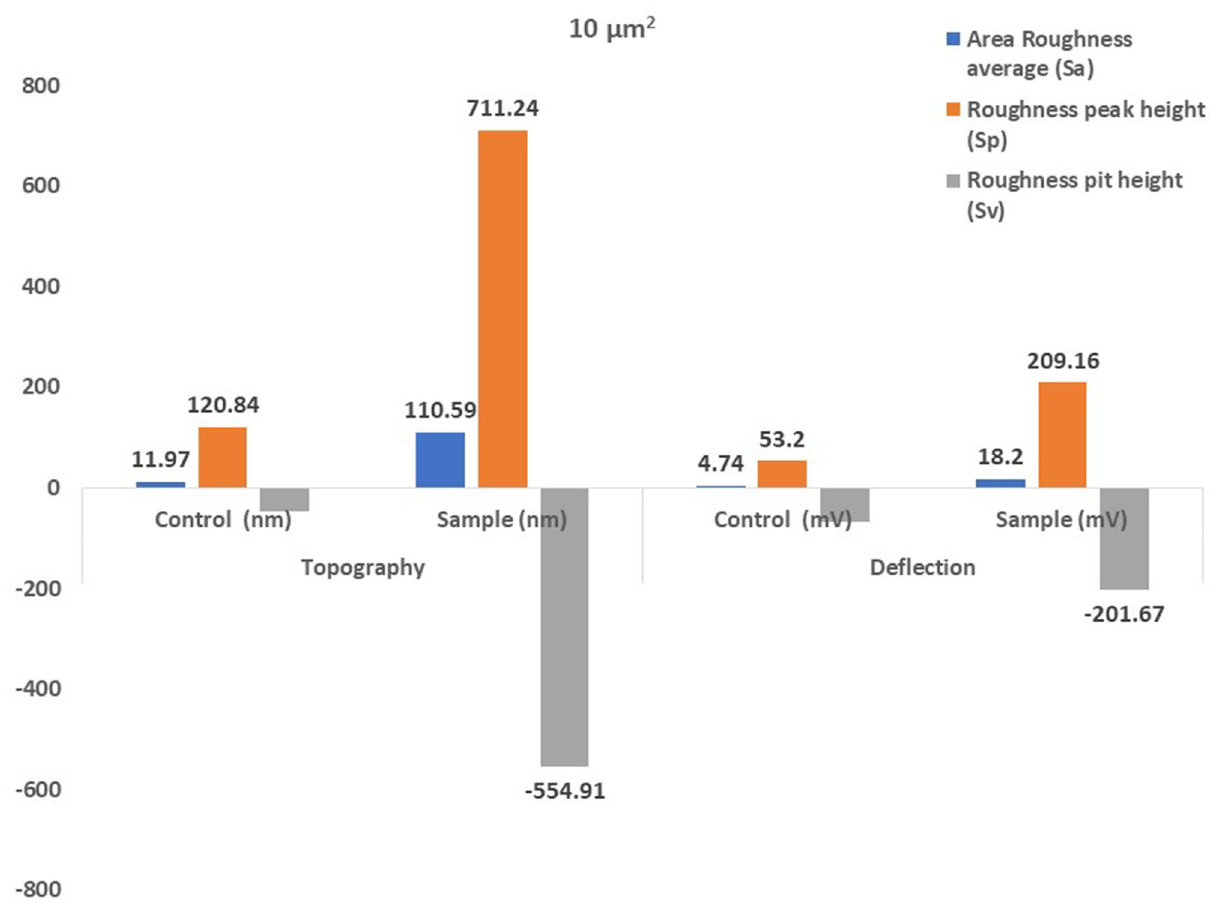
Figure 25. The bar graph showing differences in Area Roughness average (Sa), Roughness peak height (Sp), and Roughness pit height (Sv), comparatively between the control (untreated) and the U. africanum treated LDPE sheets of 10 µm 2